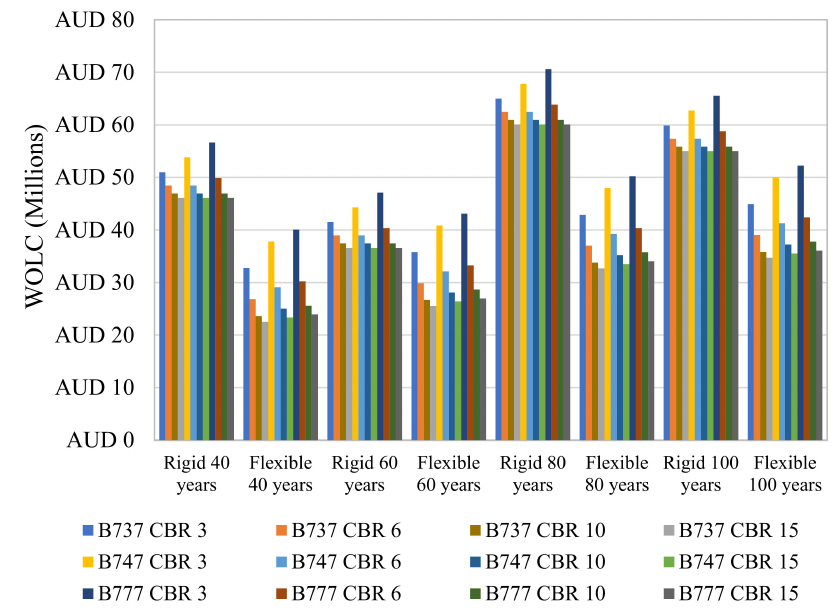
Figure 9. WOLC cost for different analysis periods at 5% discount rate.